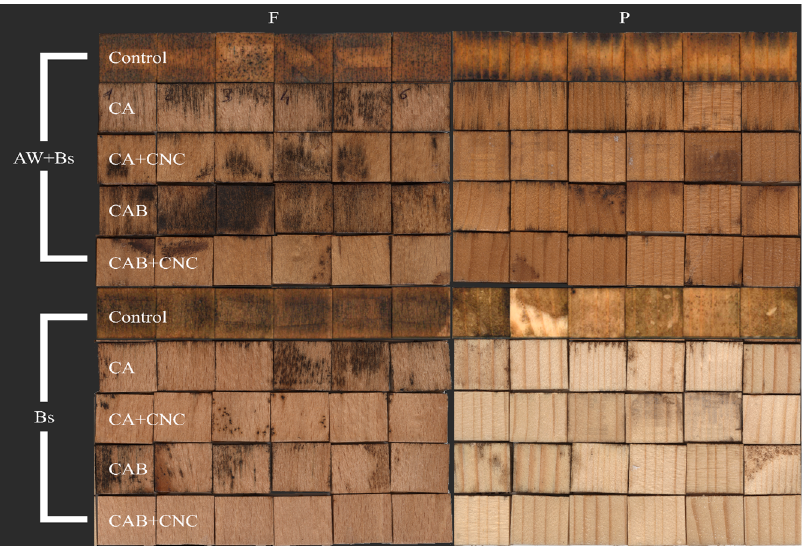
Figure 6. Blue stained samples. AW+Bs: Samples exposed to blue stain fungi after artificial weathering. Bs: Samples exposed to blue stain fungi only. Blue staining was performed on artificially weathered (AW+Bs) and